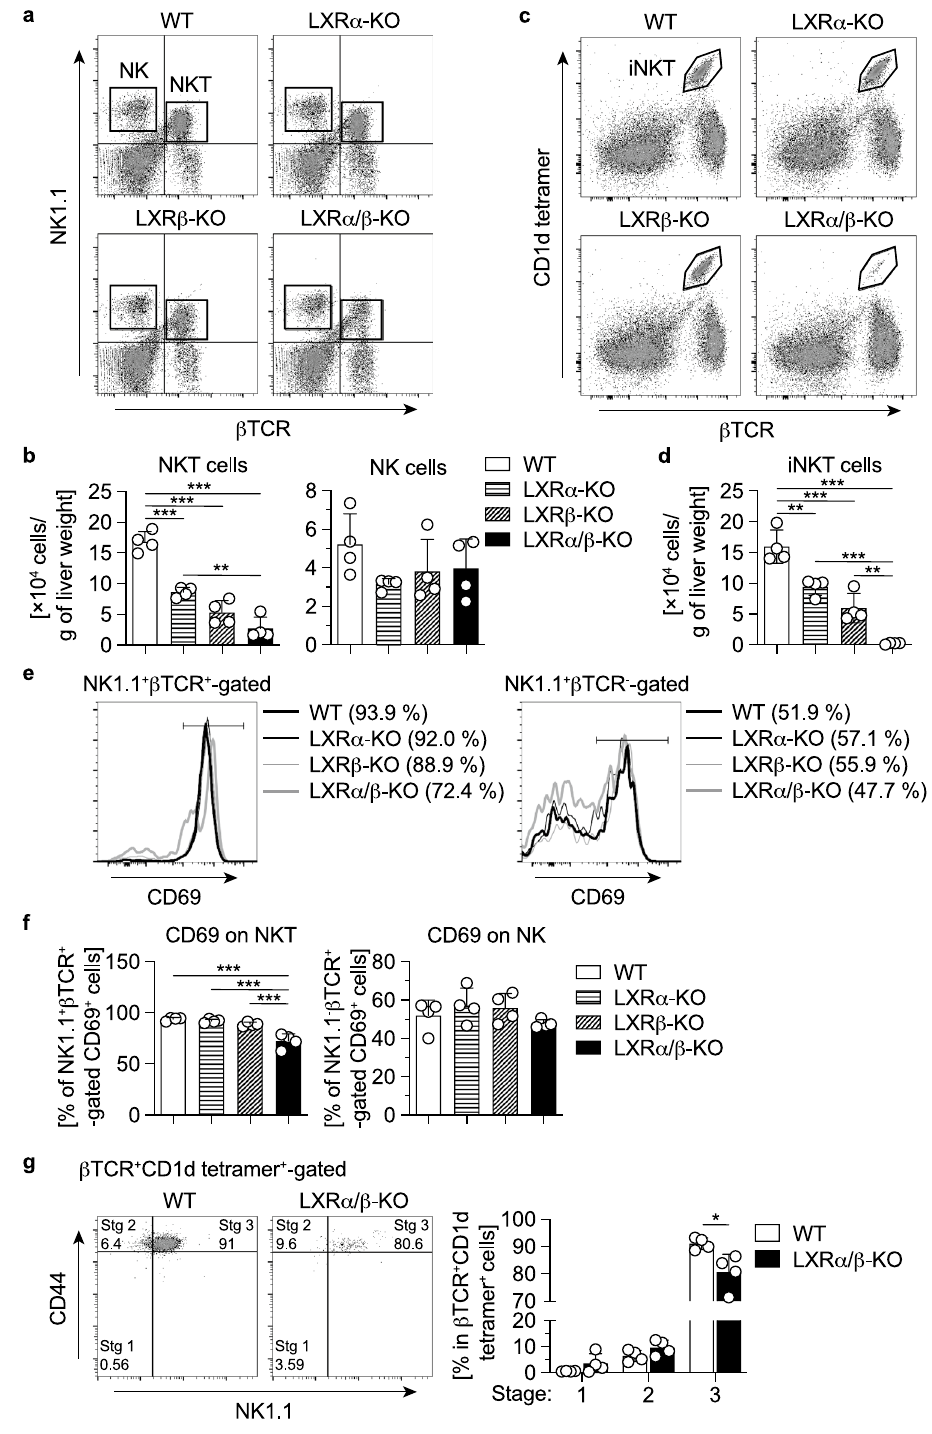
Figure 1. Decreased population of iNKT cells in the liver of LXRα/β-KO mice. ( a ) Representative flow cytometry for NKT cells (NK1.1 + βTCR + ) and NK cells (NK1.1 + βTCR − ) in hepatic MNCs. ( b ) Numbers of NKT cells and NK cells. ( c ) Representative flow cytometry for iNKT cells (βTCR + CD1d-tetramer + ). ( d ) Numbers of iNKT cells. ( e ) Representative flow cytometry for CD69 expression in NK1.1 + βTCR + -gated NKT cells and NK1.1 + βTCR − -gated NK cells. ( d ) Numbers of CD69- positive cells in NKT cells and NK cells. ( f ) Percentages of NK1.1 − CD44 − cells (stage 1), NK1.1 − CD44 + cells (stage 2) and NK1.1 + CD44 + cells (stage 3) in iNKT cells. Hepatic MNCs were isolated from WT, LXRα-KO, LXRβ-KO and LXRα/β-KO mice and stained with fluorescein isothiocyanate-conjugated (FITC-conjugated) anti-βTCR, phycoerythrin-conjugated (PE-conjugated) anti-NK1.1, biotin-conjugated anti-CD69 and PE-Cy5-streptavidin ( a , b , d and e ), with PE-conjugated CD1d tetramer and PE-Cy5-conjugated anti-βTCR ( c and d ) or with FITC-conjugated anti-NK1.1, PE-conjugated CD1d tetramer, PE-Cy5-conjugated anti-βTCR and allophycocyanin-conjugated (APC-conjugated) anti-CD44 ( g ) (n = 4). ( a - f ) ** P < 0.01, *** P < 0.001 (one-way ANOVA followed by Tukey’s multiple comparisons). ( g ) Stg, stage. * P < 0.05 (Student’s t